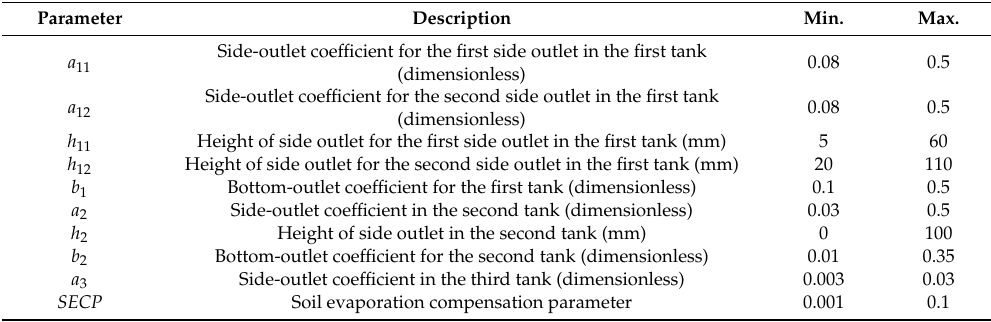
Table 1. Value ranges of 3-Tank model parameters